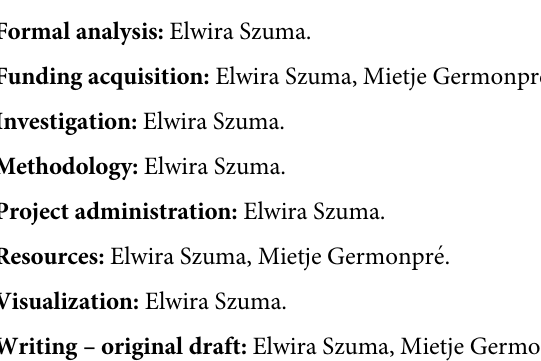
S4 Table. List of dental morphotypes used to assess of dental polymorphism in the red fox ( Vulpes vulpes ) and the arctic fox ( Vulpes lagopus